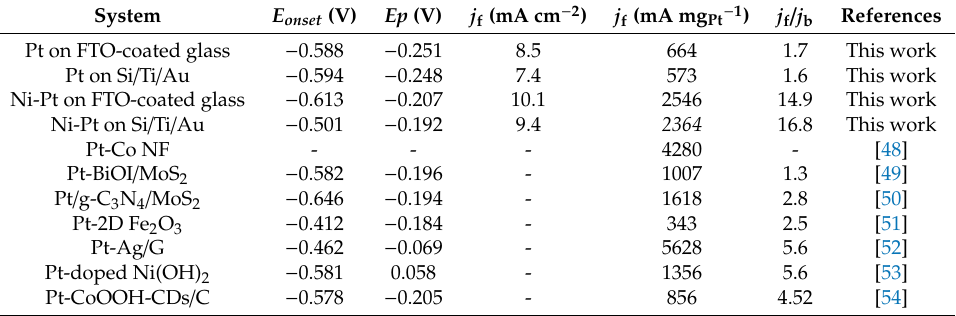
Table 3. Catalytic performance of Pt-based electrocatalysts for methanol electro-oxidation in a solution